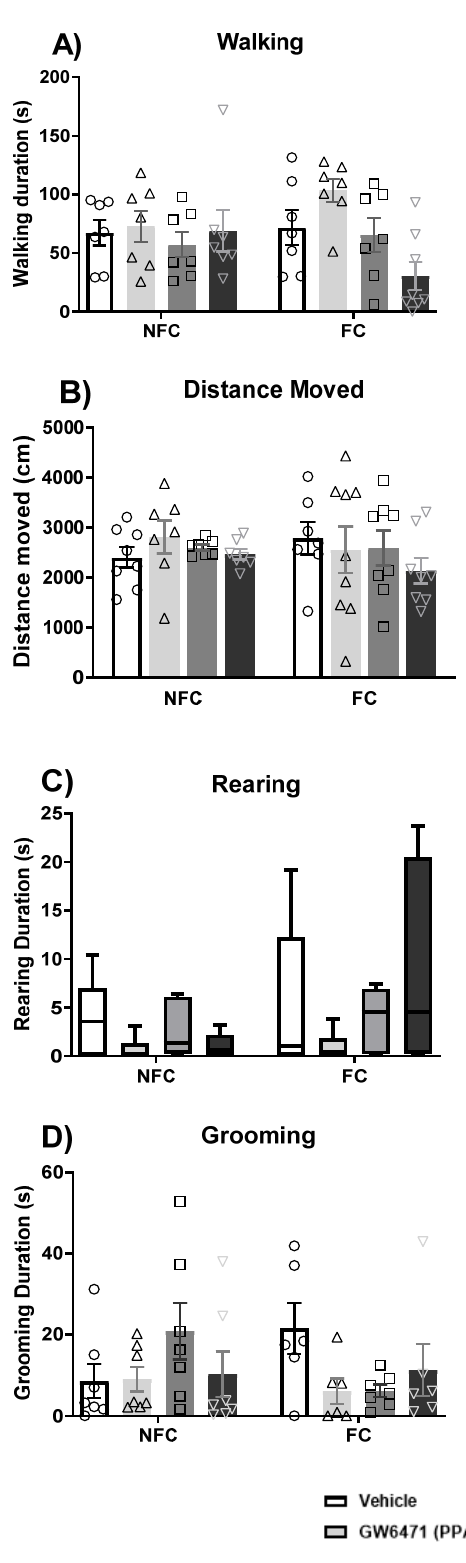
Figure 5. Effects of fear-conditioning and intra-BLA administration of selective PPAR α , PPAR β / δ , and PPAR γ antagonists on walking duration ( A ), distance moved ( B ), grooming duration ( C ), and rearing duration ( D ). Data are expressed as mean ± S.E.M. ( A , B , D ) or median with interquartile range and min/max ( C ), each symbol represents one individual, n = 7–9 rats per